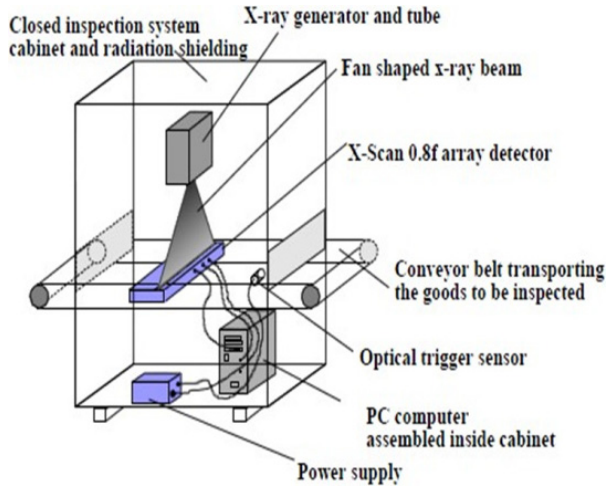
Fig. 1. Diagram of X-ray inspection